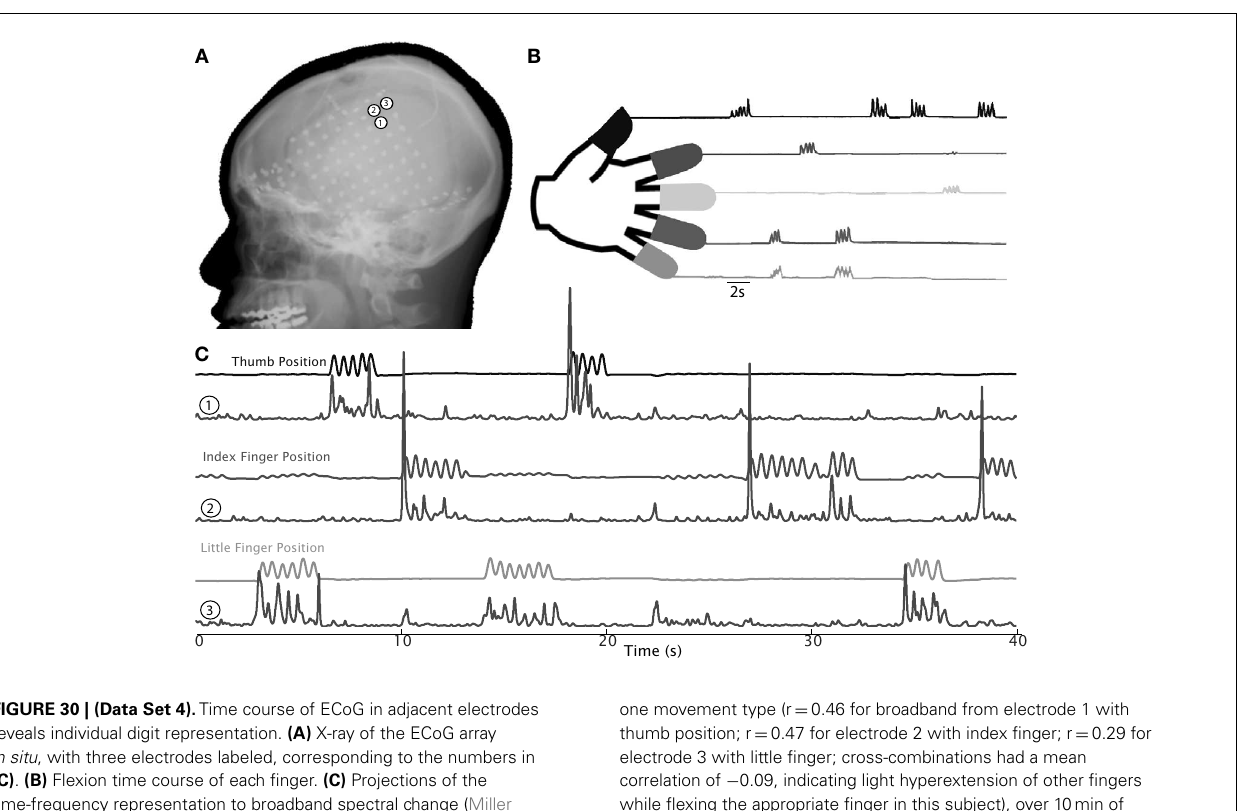
FIGURE 30 | (Data Set 4). Time course of ECoG in adjacent electrodes reveals individual digit representation. (A) X-ray of the ECoG array in situ , with three electrodes labeled, corresponding to the numbers in (C) . (B) Flexion time course of each finger. (C) Projections of the time-frequency representation to broadband spectral change (Miller et al., 2009b). Each electrode is specifically and strongly correlated with